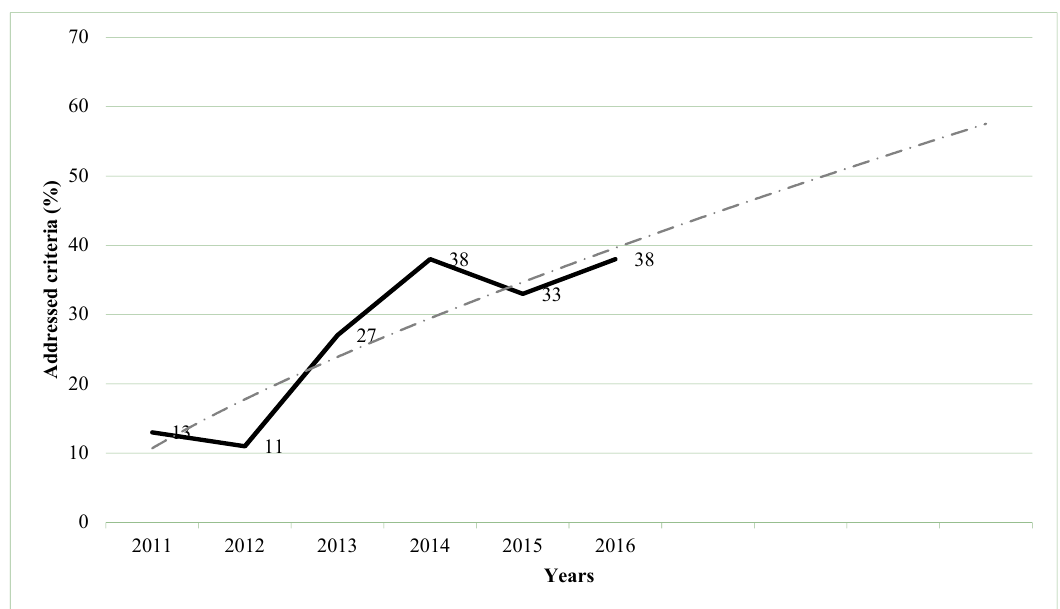
Figure 3. Percentage of criteria addressed with a trend line.